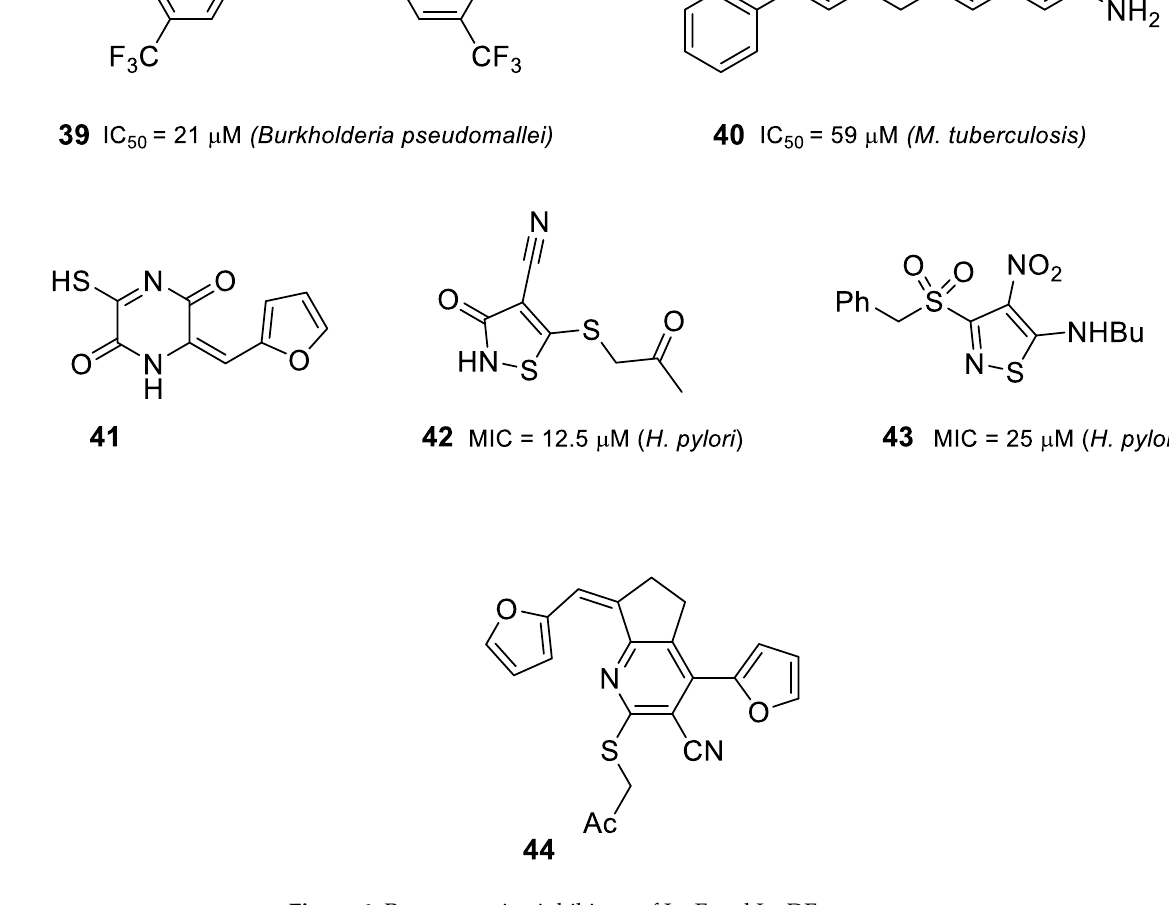
Figure 6. Representative inhibitors of IspF and IspDF.